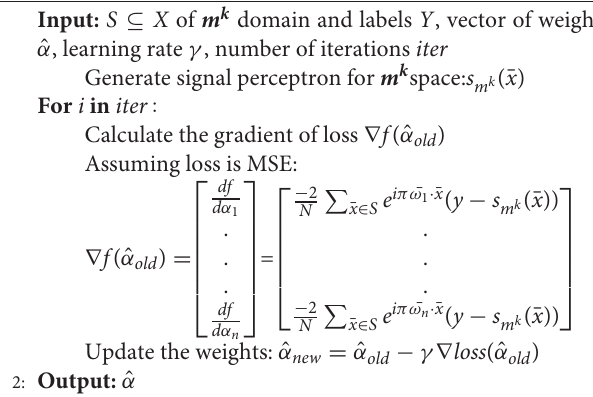
Algorithm 2 Gradient descent based learning algorithm for the signal